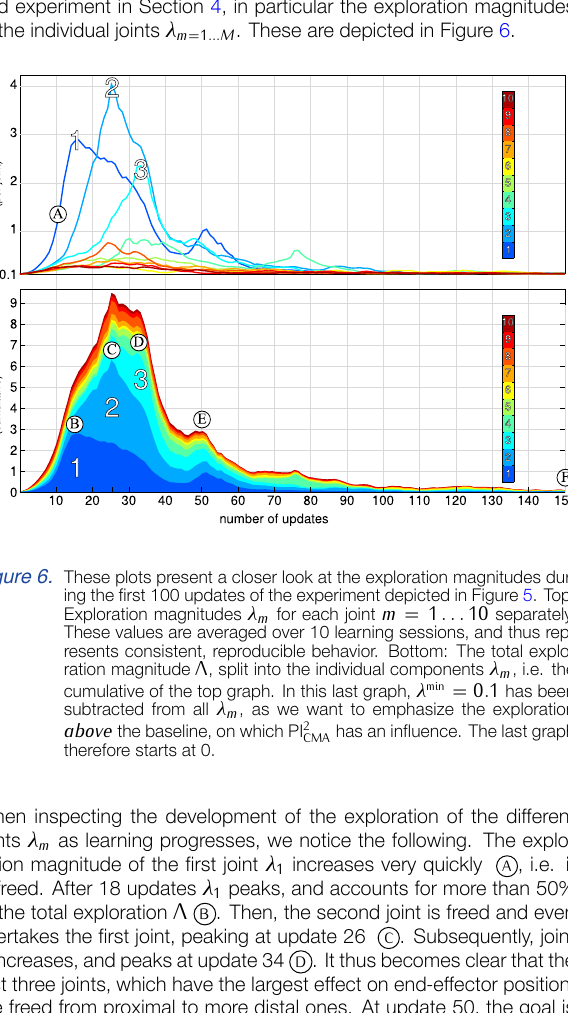
Figure 5. Top: x -coordinate of the task goal. Center: Learning curve ( µ ± σ over 10 learning sessions). Note the logarithmic y -axis. Bottom: To- tal exploration magnitudes over all joints Λ ( µ ± σ over 10 learning